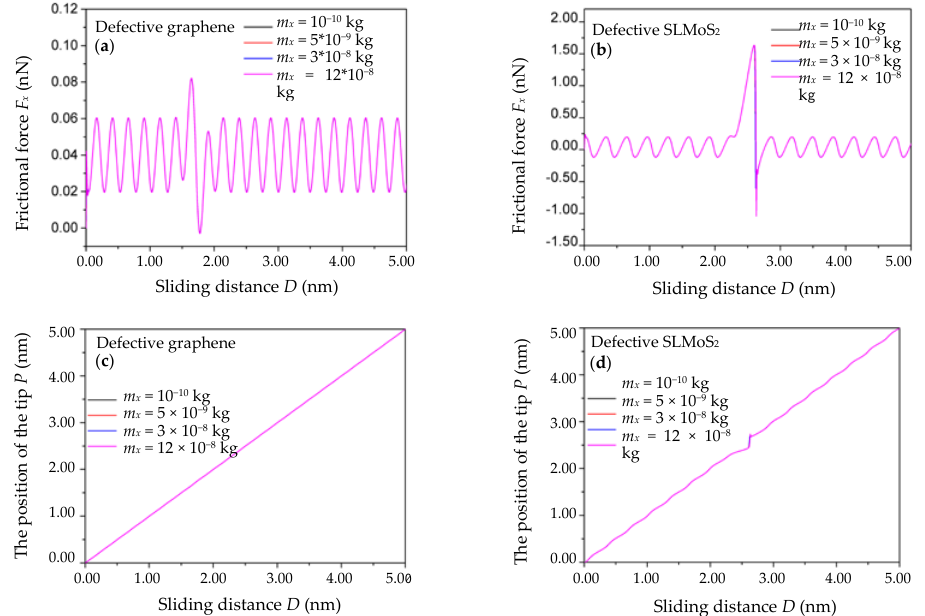
Figure 3. The frictional force F x vs. the sliding distance D curves of the monovacancy-defective graphene ( a ) and SLMoS 2 ( b ) with di ff erent e ff ective masses m x of the system. The position of the single-atom tip P vs. the scanning distance D curves of the monovacancy-defective graphene ( c ) and SLMoS 2 ( d ) with di ff erent e ff ective masses m x of the system. The curves in Figure 3 look like a single curve, but they are the overlap of multiple curves, and the displayed curves are the pink curves.